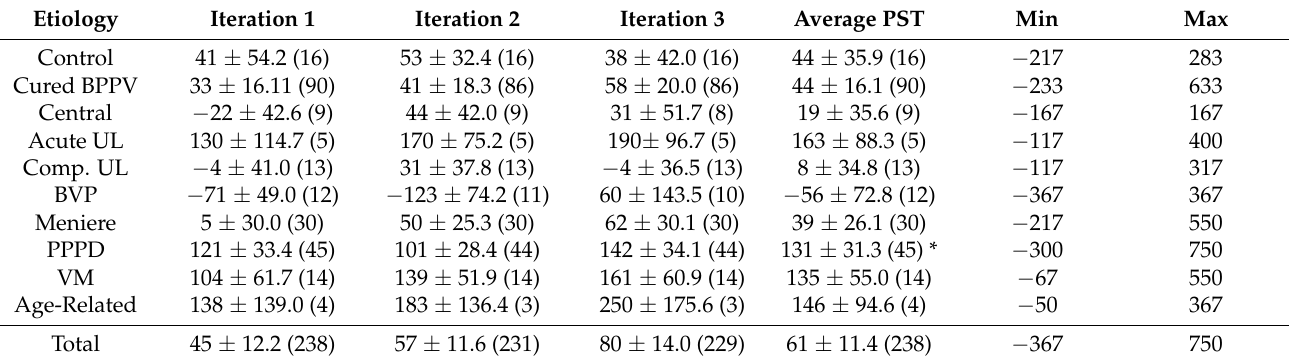
Table 3. PST as a function of etiology categories. Values are presented as mean ± standard error of mean (n) in milliseconds. PST: peak-sound threshold. BPPV: benign paroxysmal positional vertigo, UL: unilateral loss, PPPD: persistent postural-perceptual dizziness, BVP: bilateral vestibulopathy,